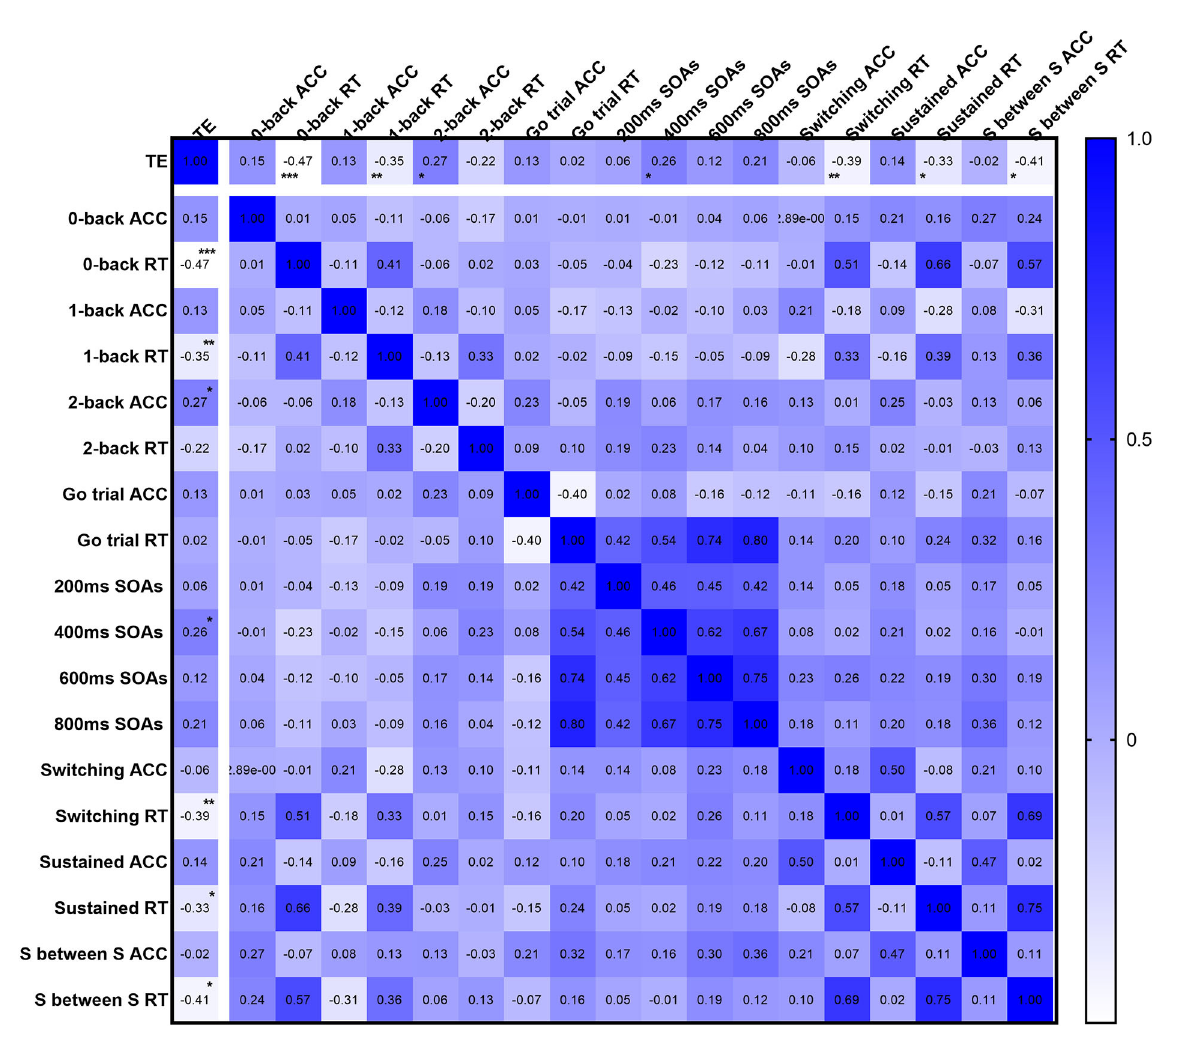
FIGURE4 The heat map of the correlation coefficient ( r ) matrix. TE, training experience; ACC, the accuracy of each executive functions task; RT, the reaction time of each executive functions task; SOAs, stimulus onset asynchronies; S between S, Sustained between Switching block. * Statistically significant with P < 0.05, ** statistically significant with P < 0.01, *** statistically significant with P <